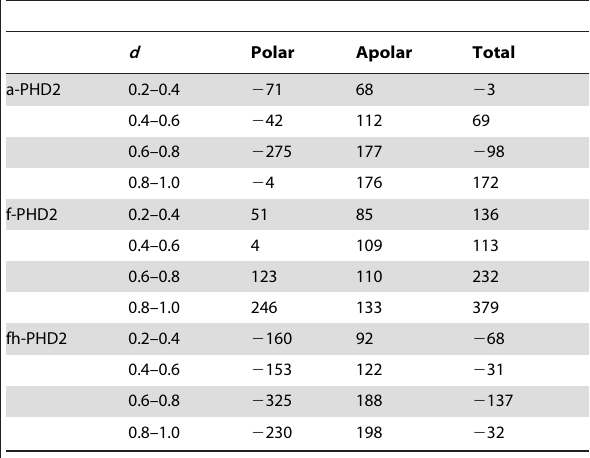
Table 1. The changes of protein solvation free energy upon